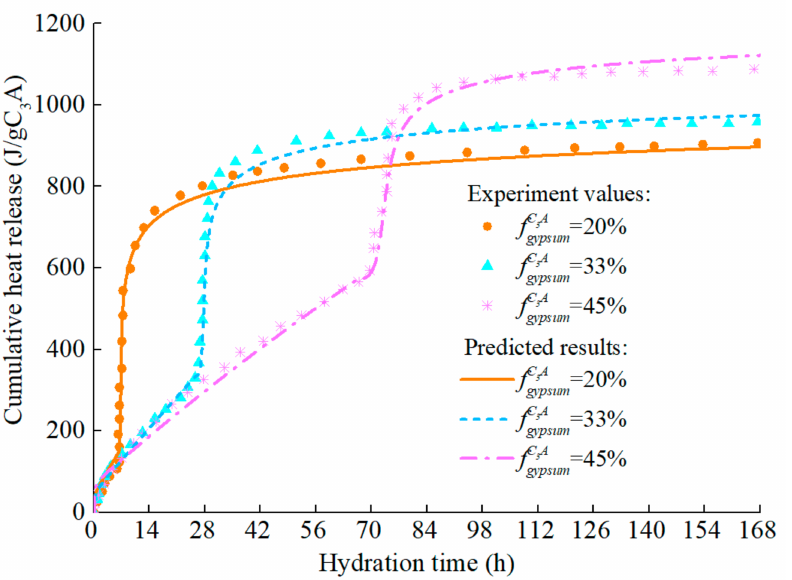
Figure 15. Hydration heat of C 3 A in C 3 A- gypsum system with different gypsum content (fine particle, w/c =